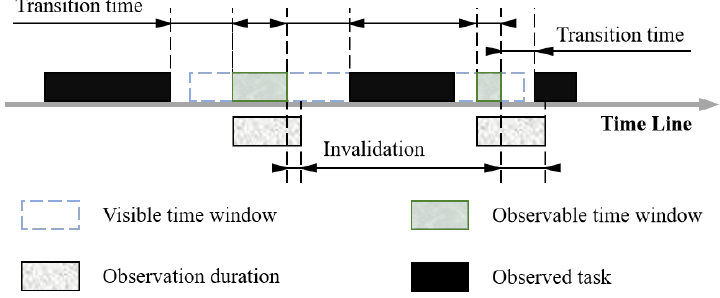
Figure 7. Observation arrangement process for tasks deleted due to constraint